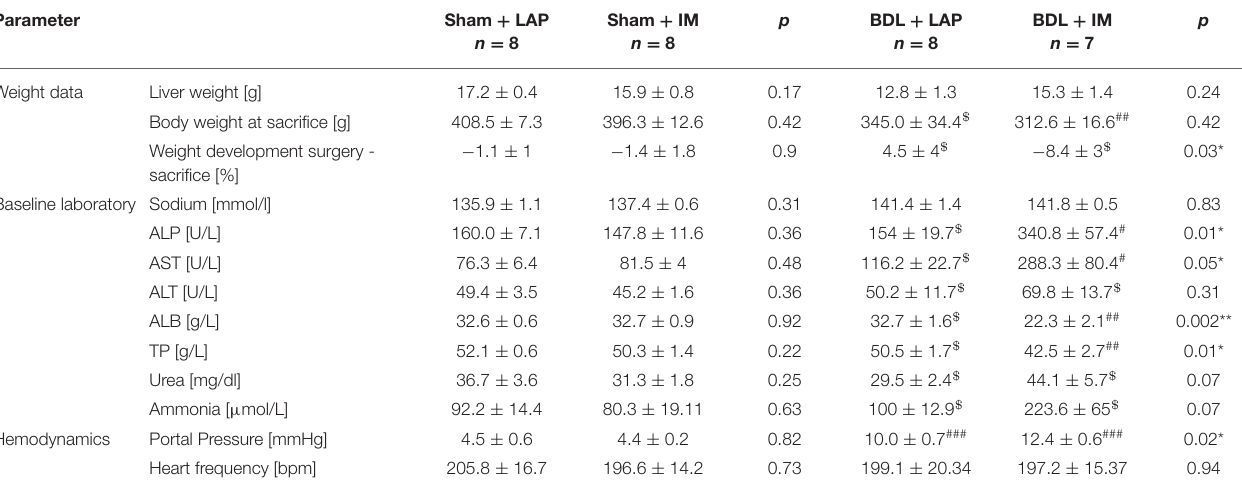
TABLE 1B | General characteristics and clinical data of rats undergoing Sham/BDL at sacrifice 7 days after IM/LAP. Parameter